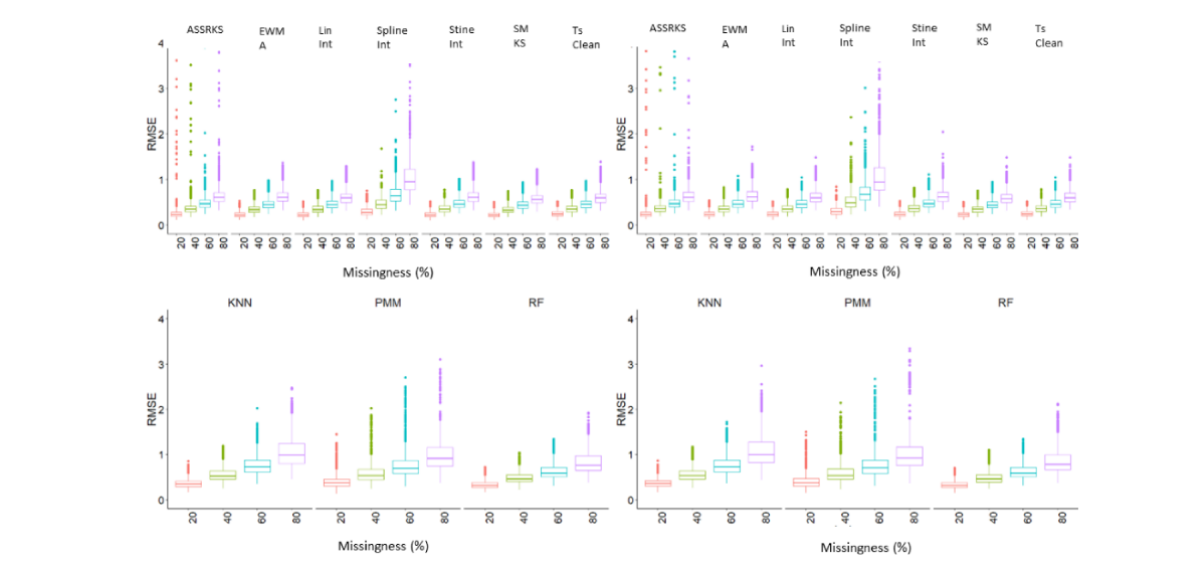
Figure 3. Illustration of linear and non-linear calculation of body weight variability. Scatterplots represent an example of a single participant with a non-linear weight trajectory over 12-months. Figure (A) shows a linear trendline fitted to the data with (B) the trendline subtracted and the associated residuals plotted. Figure (C) shows a non-linear locally estimated scatterplot smoothing regression fitted to the data with (D) the trendline subtracted and the associated residuals plotted. RMSE: root mean square